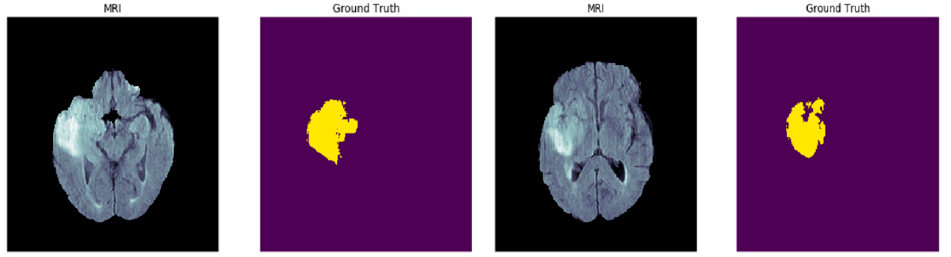
Figure 8. Sample magnetic resonance imaging (MRI) images and their ground truth labels from the Brain Tumor Segmentation (BRATs) dataset.